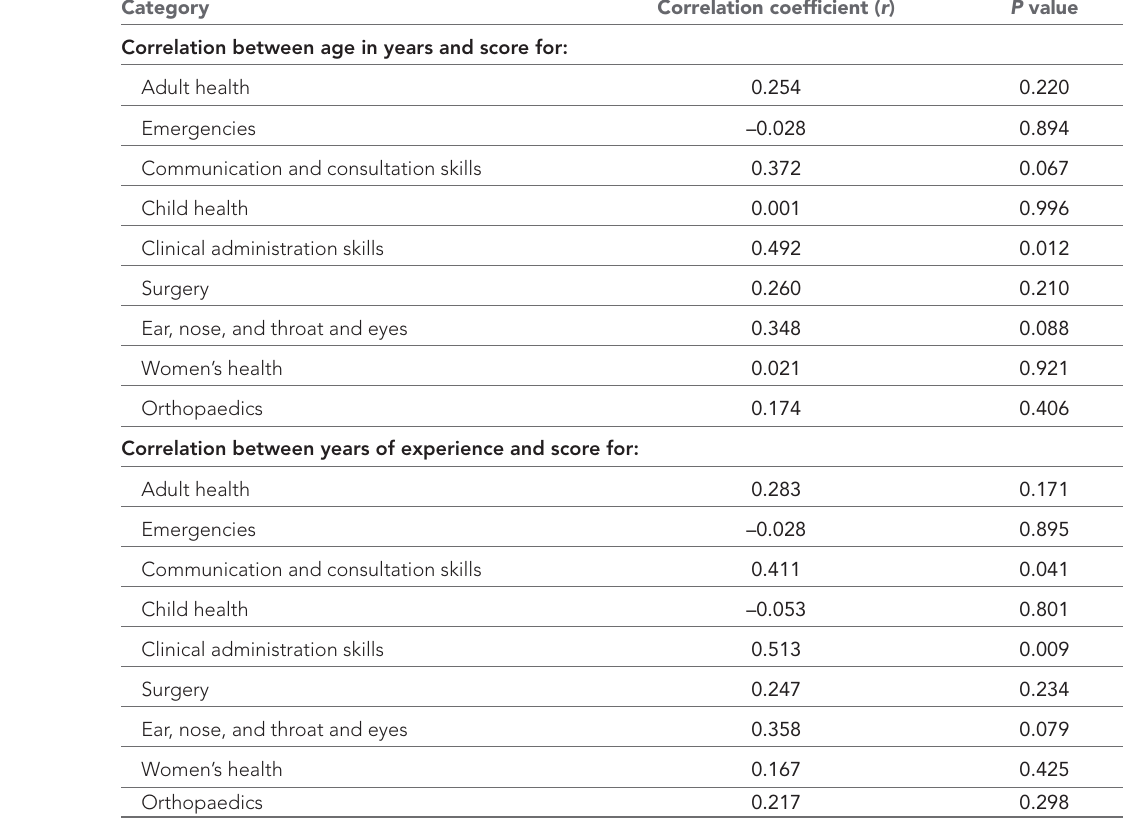
Table 4 Relationship between age and years of experience and self- reported performance of skills by